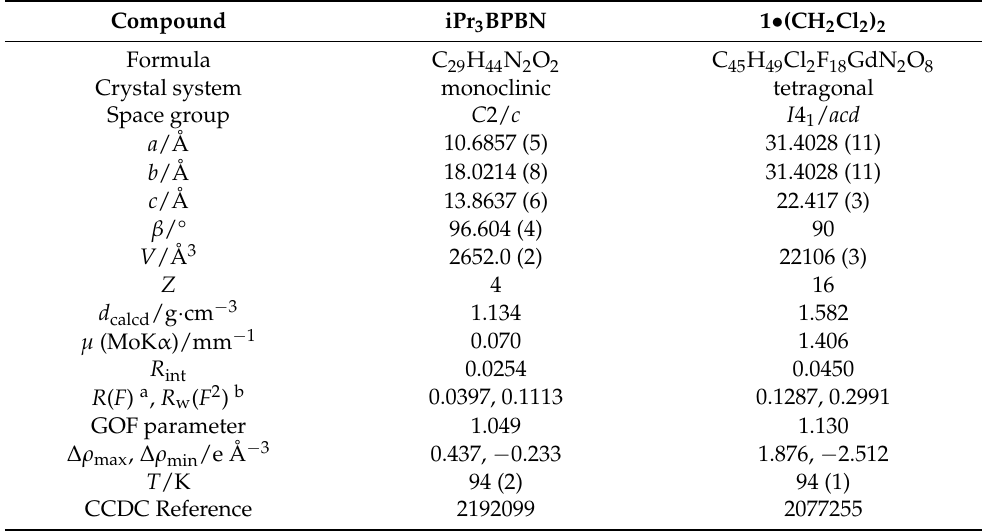
Table 1. Selected crystallographic parameters on iPr 3 BPBN and 1 • (CH 2 Cl 2 ) 2